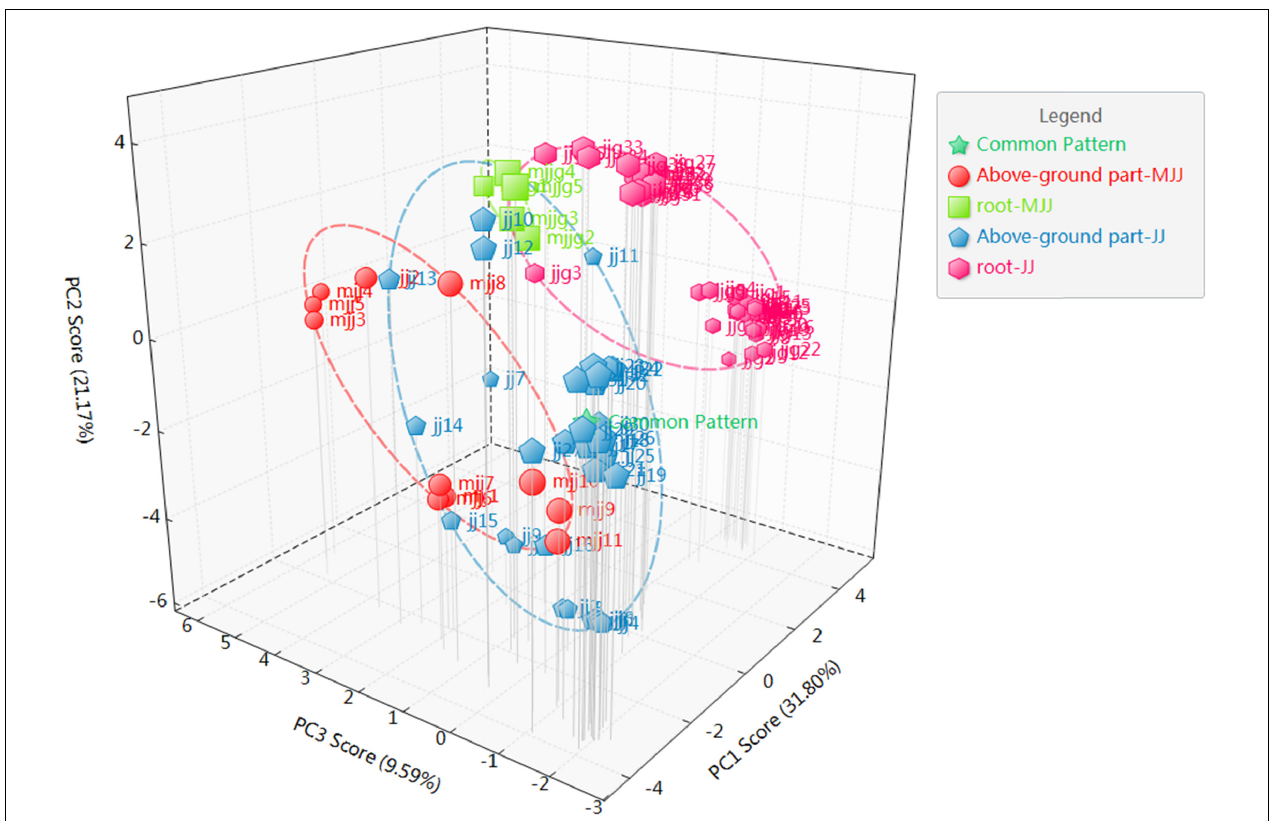
FIGURE 4 | PCA analysis of different medicinal parts (above-ground parts and roots) of chicory.